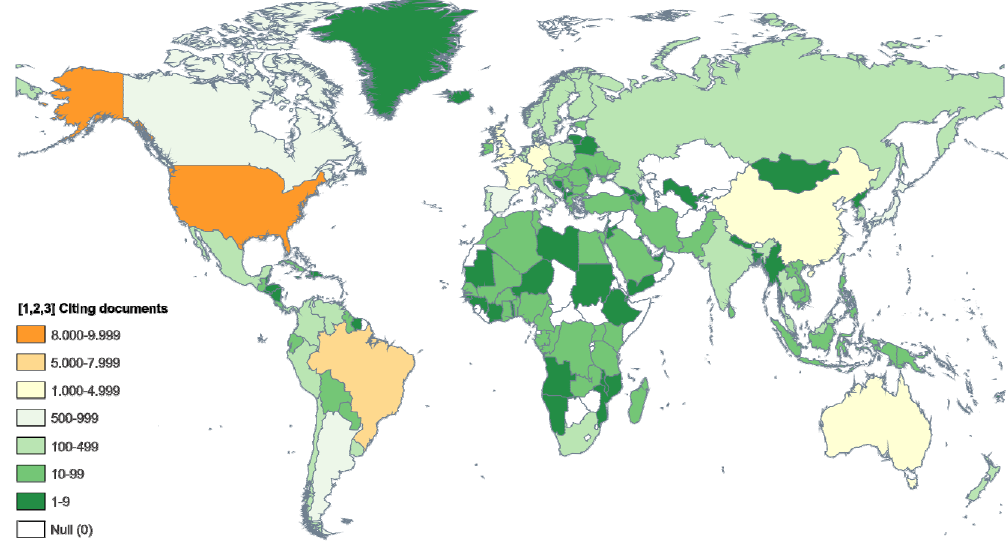
Figure 5. Geographical distribution of citations received by Brazilian scientific output in Evolutionary Biology published between 2000 and 2012 (January 2000–March 2015). Most of the citations come from seven major countries: United States, with 9859 (54.6%); Brazil, with 5458 (30.2%); United Kingdom, with 1827 (10.1%); Germany, with 1339 (7.4%); France, with 1213 (6.7%); Australia, with 1023 (5.7%); and China, with 1011 citing documents (5.6%). Nevertheless,